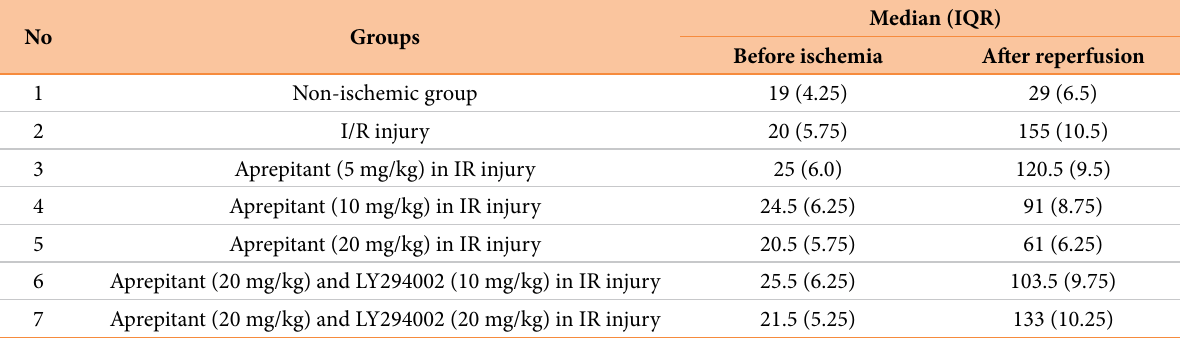
Table 2 - Values of CK-MB in median (IQR) in aprepitant and LY294002-treated animals in ischemia-reperfusion induced